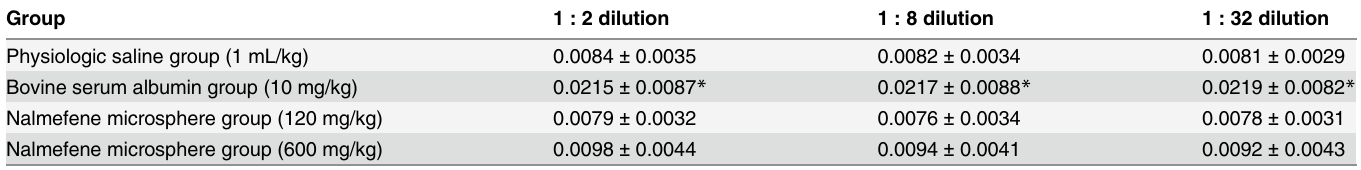
Table 3. Optical density (OD) values at day 30 after the passive cutaneous anaphylaxis test in rats (n = 4).